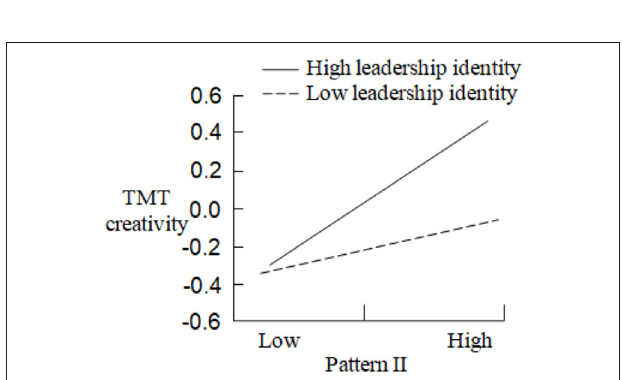
FIGURE 4 | The moderating effect of leadership identity in the relationship between pattern II and TMT creativity.